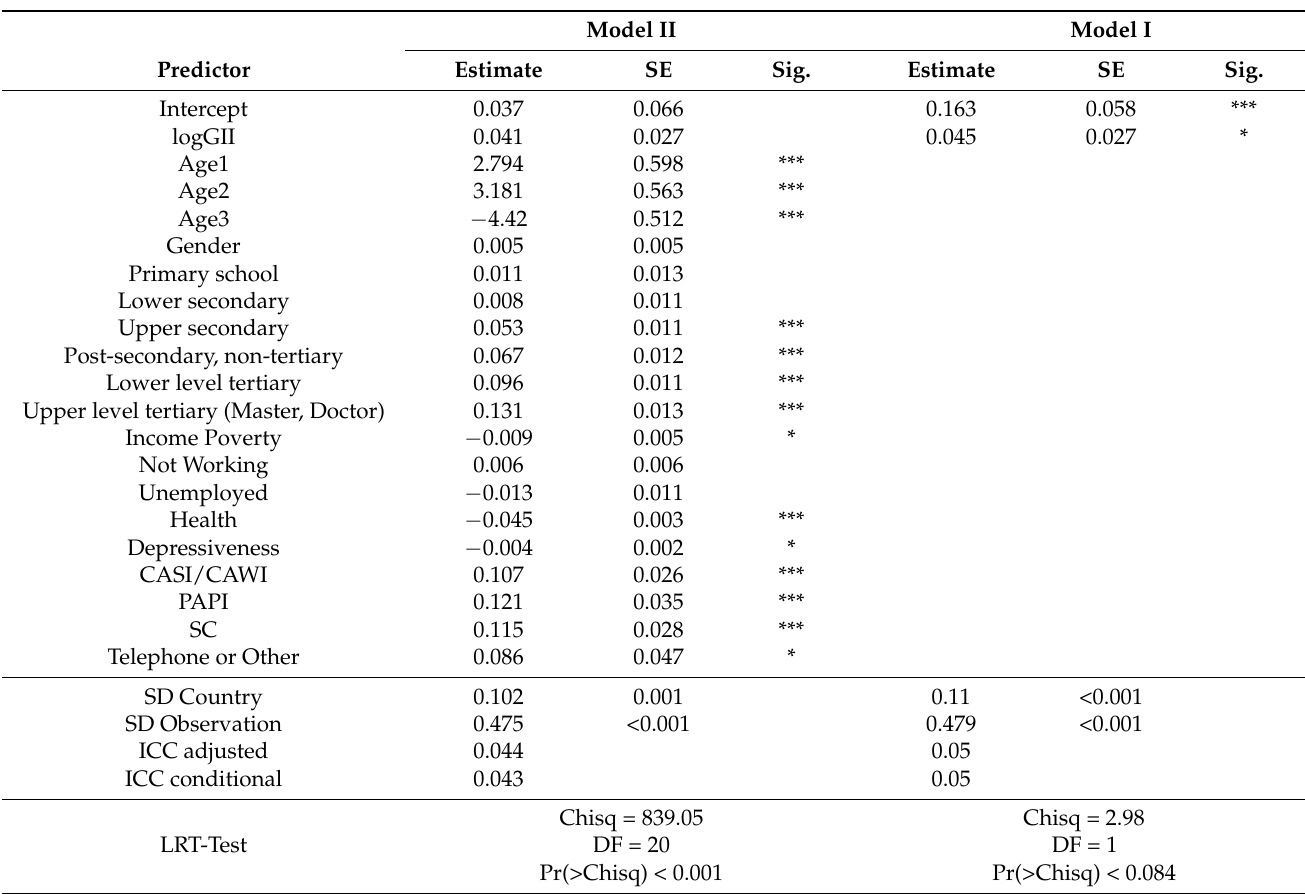
Table A6. Multilevel linear regressions of the effect of GII on SNI community (Full Table